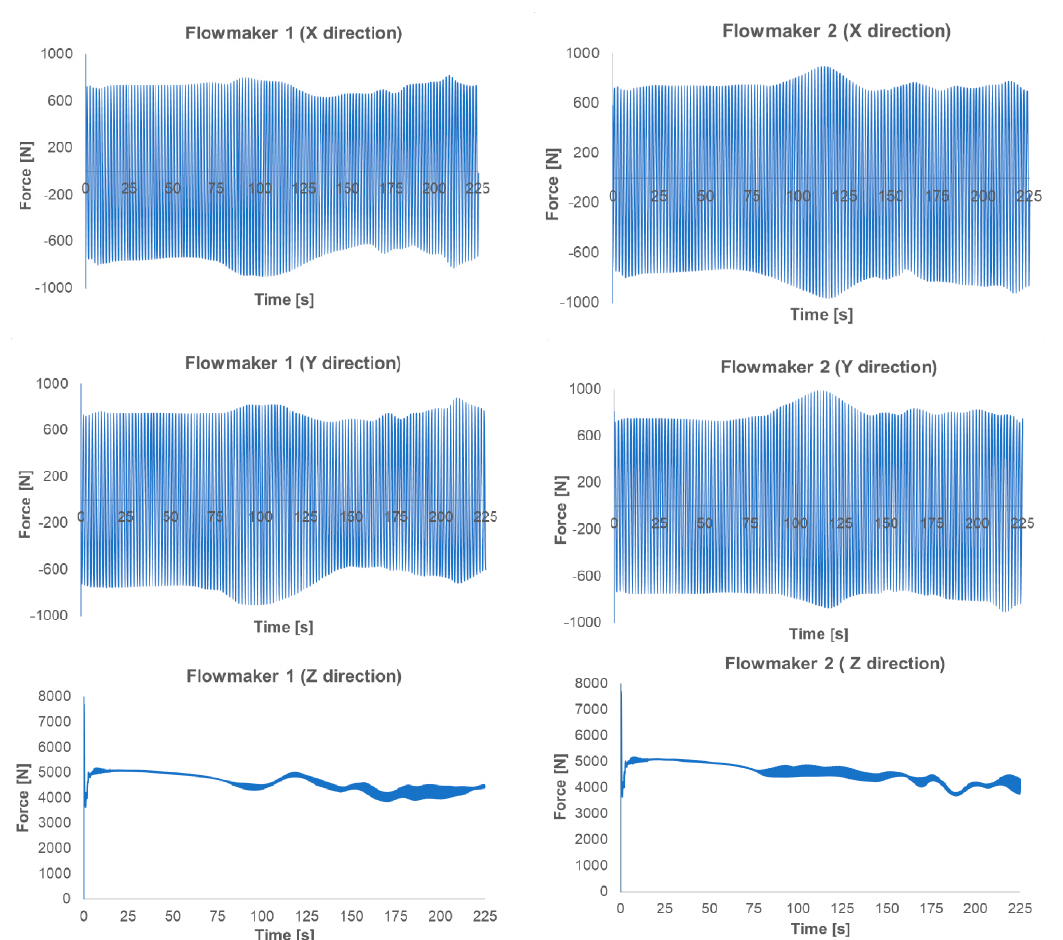
Figure 9. Normal force on the blades of the flowmakers in axial (Z) and radial (X and Y) directions.